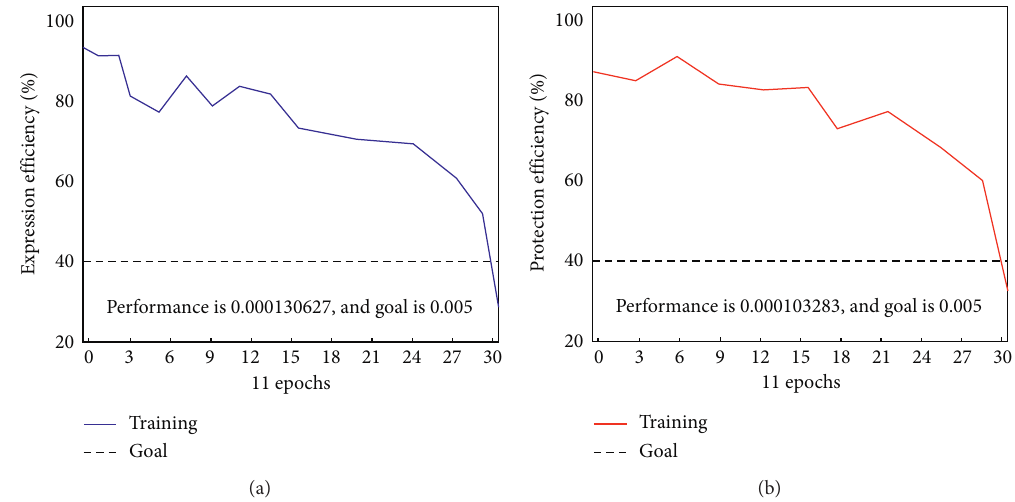
Figure 6: Intellectual property expression efficiency and protection efficiency of educational resource data based on machine learning. (a) Intellectual property expression. (b) Intellectual property protection.